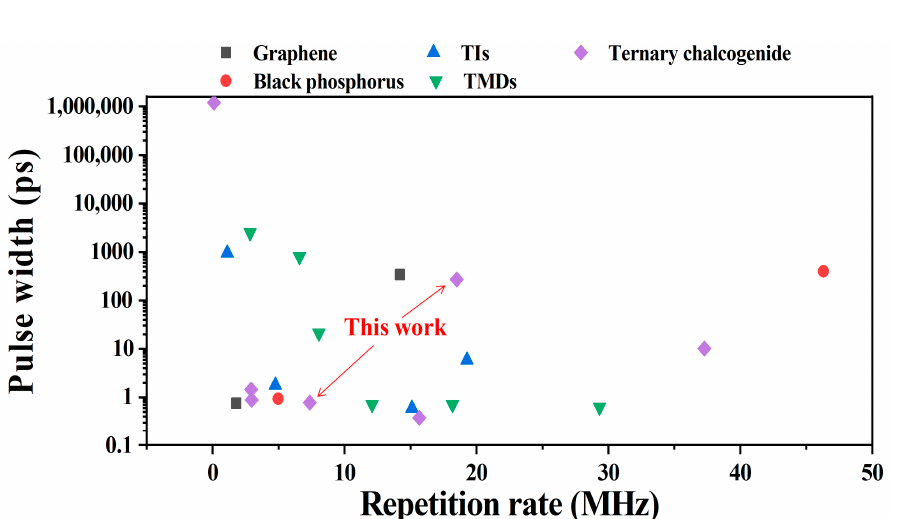
Figure 10. Pulse width versus repetition rate of PQS solid-state lasers based on different new 2D materials.